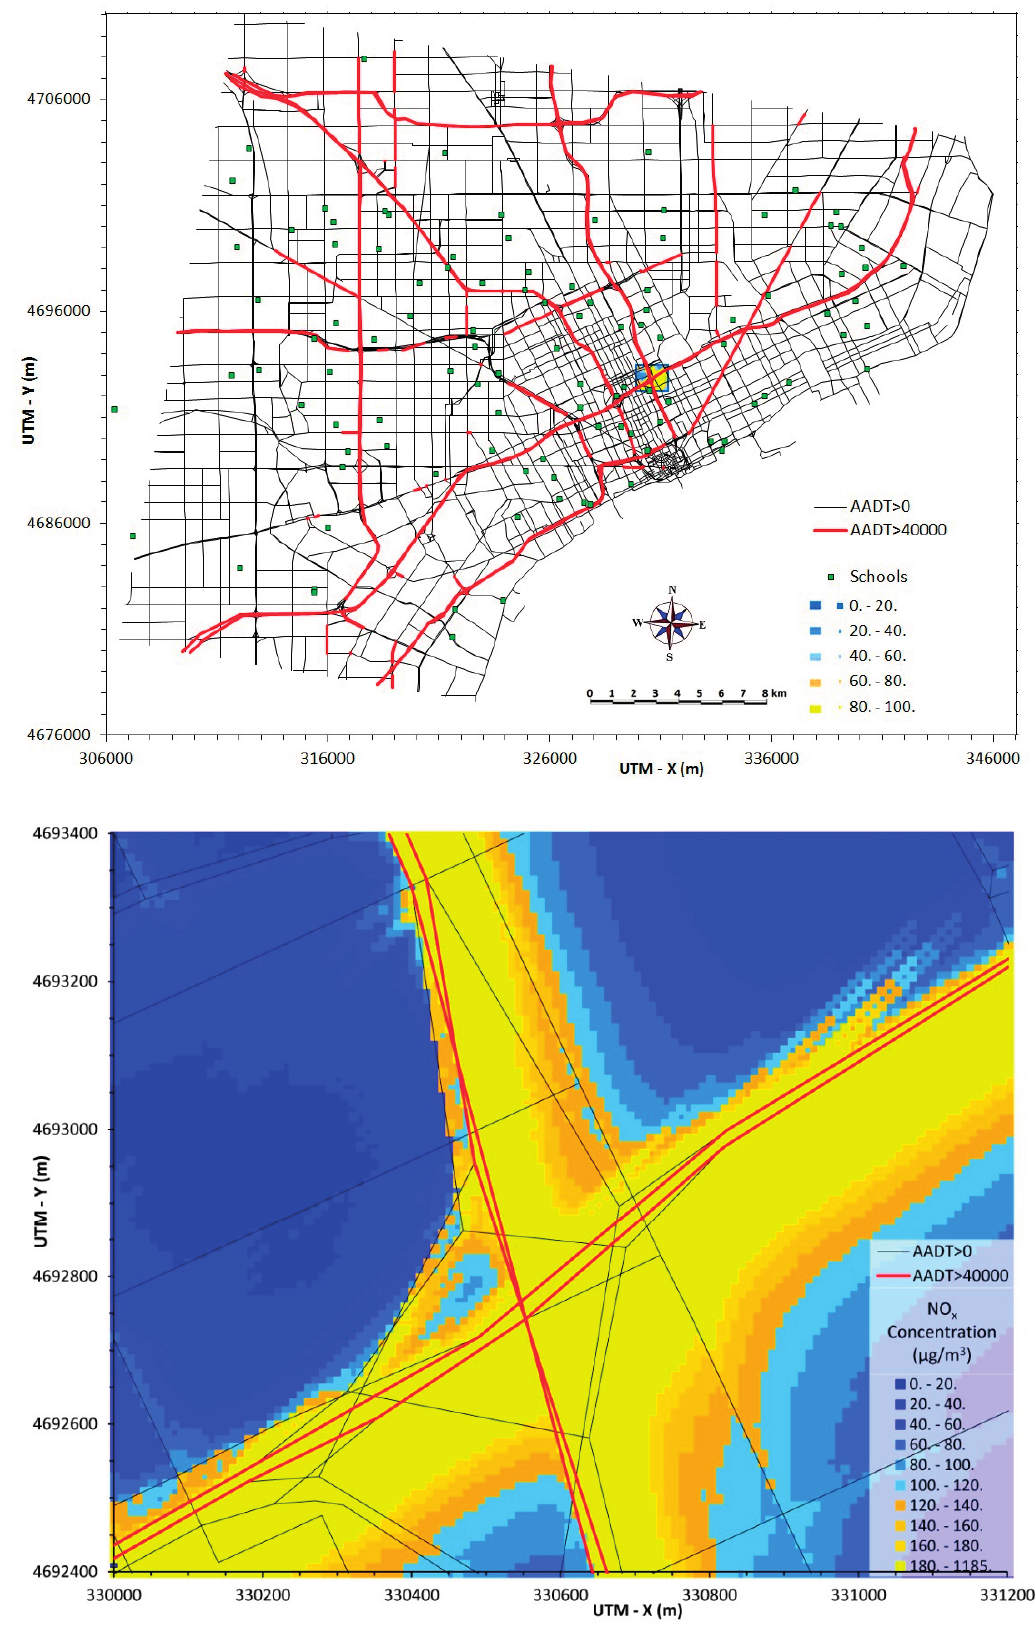
Figure 5. NO X concentrations from traffic emissions for 11 January 2010 at 5 pm for I-75/I-94 area at 10 m resolution. Top: green arrow indicates modeled area; green squares also show locations of schools; Bottom: 1.0 × 1.2 km area